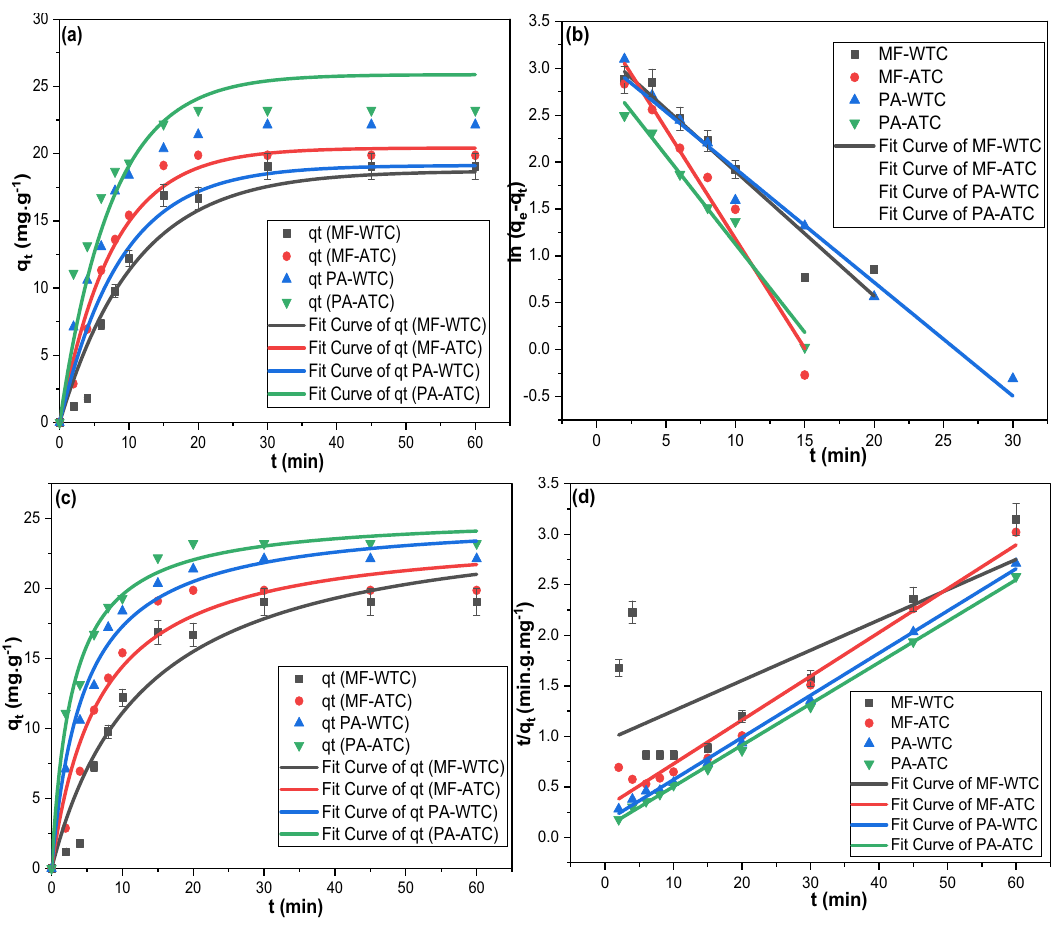
Fit Curve of qt (MF-WTC) Fit Curve of qt (MF-ATC) Fit Curve of qt PA-WTC) Fit Curve of qt (PA-ATC)